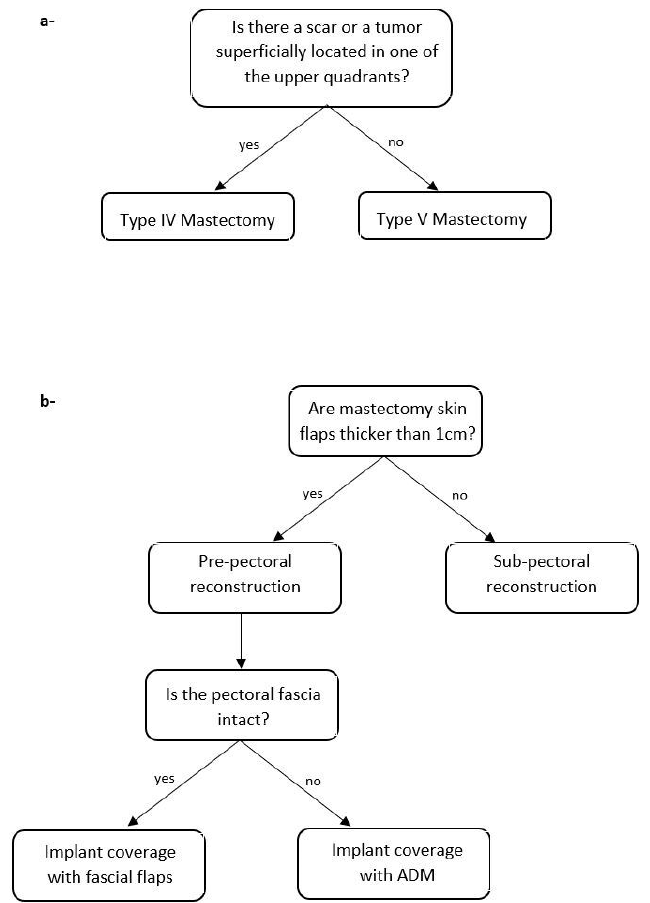
Figure 1. Institutional algorithm for immediate implant-based breast reconstruction in large and ptotic breasts: ( a ) preoperative evaluation; ( b ) intraoperative